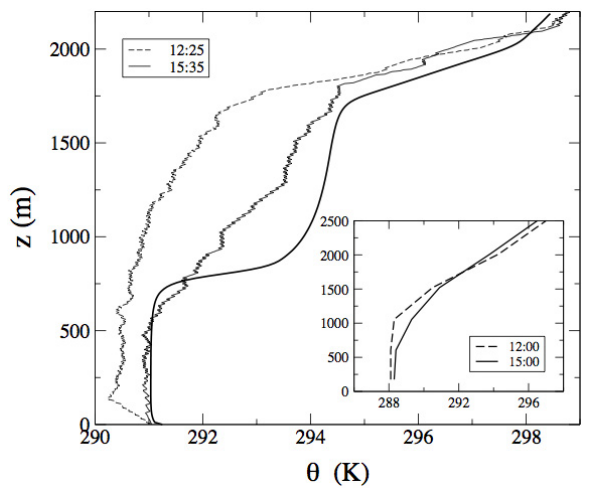
Fig. 7. Potential temperature profiles. Thin lines are the radiosound- ings at 12:25 and 15:35UTC of 16 June 1992. The thicker line is the profile from LES recorded at 15:30UTC. In the inset, two profiles obtained from the WRF